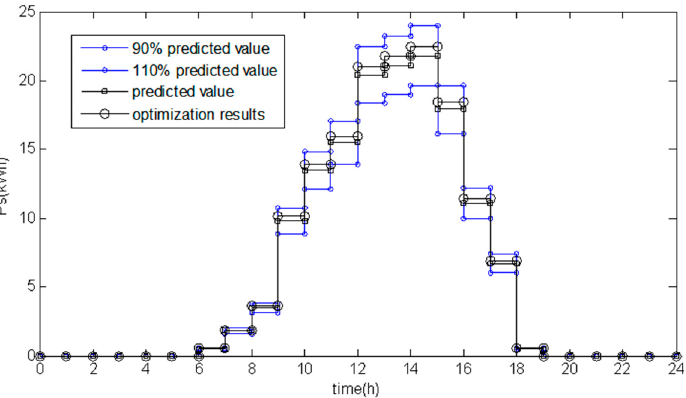
Figure 8. Output power of the photovoltaic cells and their grey domain values.